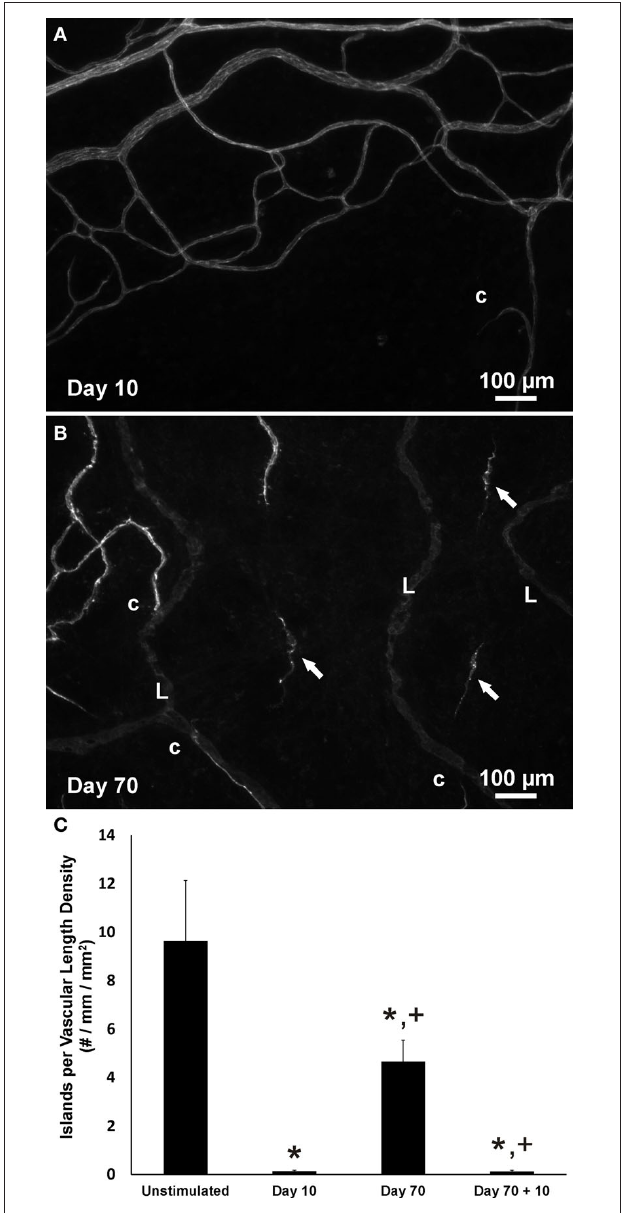
FIGURE 3 | The presence of vascular islands is associated with network regression. (A,B) Representative images of the periphery of vascular networks labeled for PECAM at day 10 (A) and at day 70 post stimulation (B) . At day 70 during microvascular network regression, the number of vascular islands (arrows) is increased. Blind ended capillary segments still connected to a network are indicated by “c.” Lymphatic vessels are indicated by “L.” (C) Quantification of the number of vascular islands per vascular length density over the time course of growth, regression, and regrowth. ∗ p < 0 . 05 compared to the unstimulated group, + p < 0 . 05 compared to the previous time point. Values are means ±